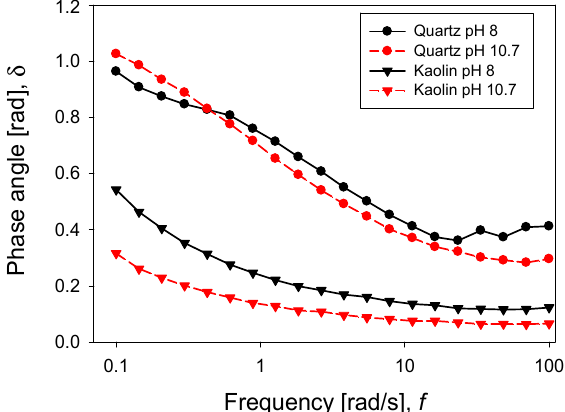
Figure 13. Phase angle for quartz and kaolin slurries at varied pH levels.